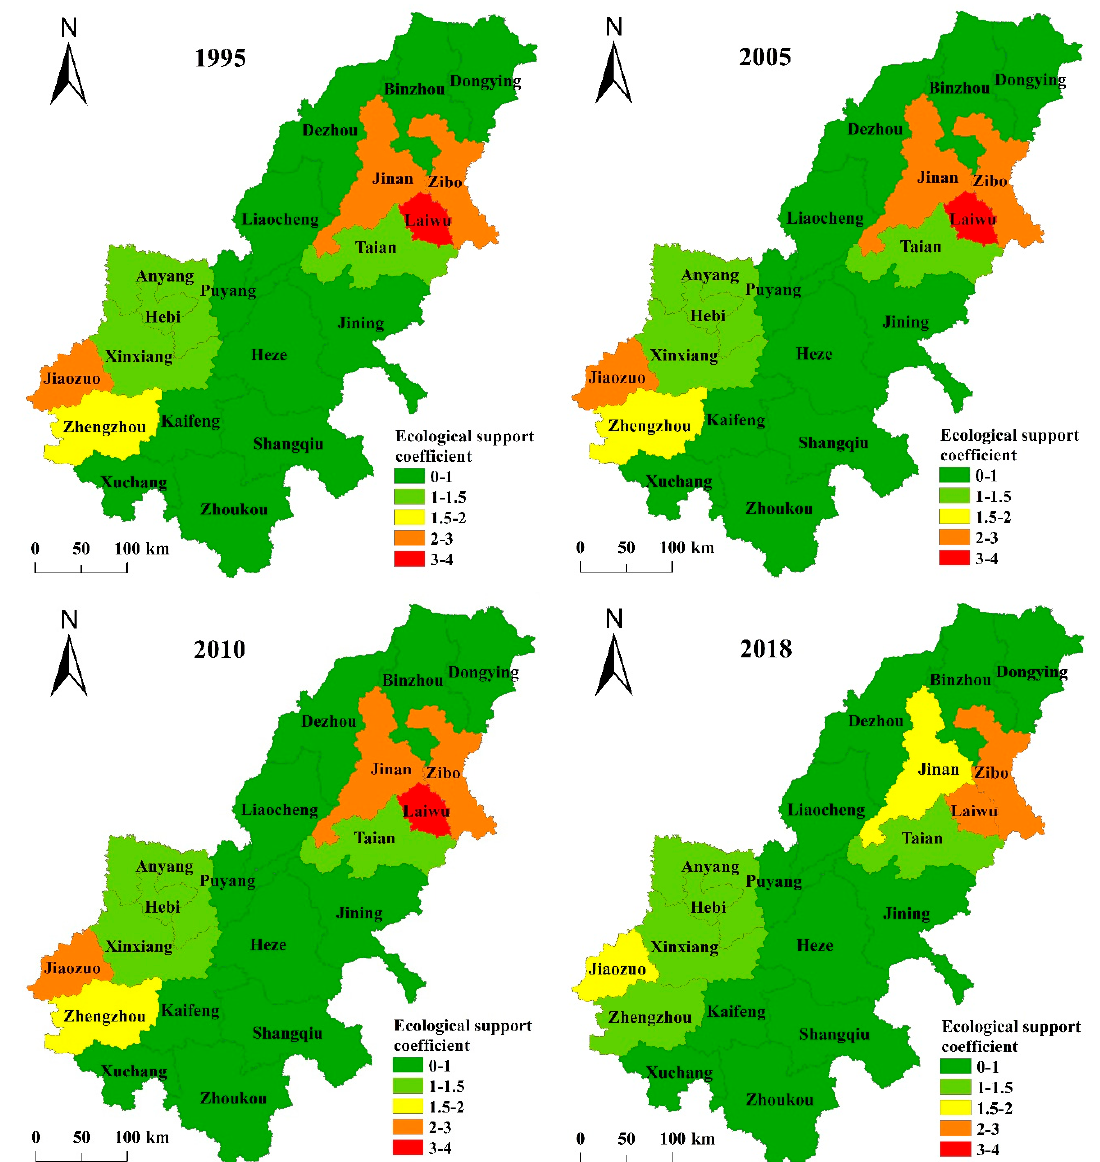
Figure 5. Spatial distribution of ecological support coefficients in prefecture-level cities of the lower Yellow River area from 1995 to 2018.